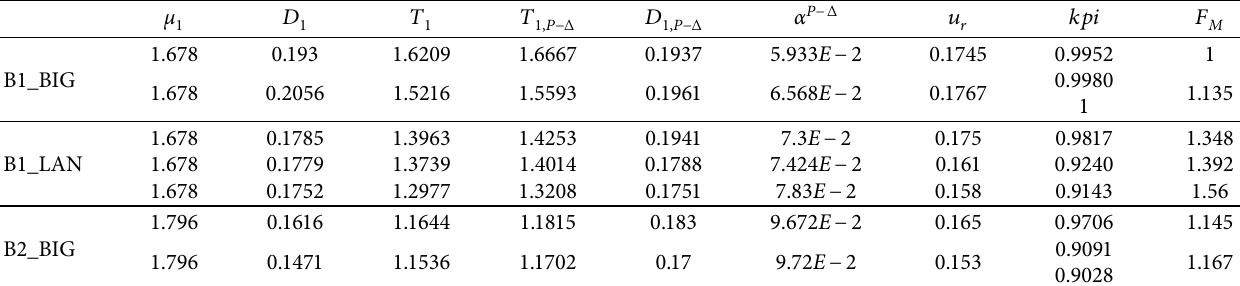
Figure 22: Building B3 under BORREGO record with diferent distributions of reinforcements: (a) comparison between NRHA and interstorey drifts limit, (b) NRHA fexural moment demands and MMPD fexural capacities of 30cm wall, (c) NRHA fexural moment demands and MMPD fexural capacities of 20cm wall, (d) NRHA/approximated MMPD shear demands and (e) NRHA/approximated MMPD torsional demands. Table 17: Design summary of